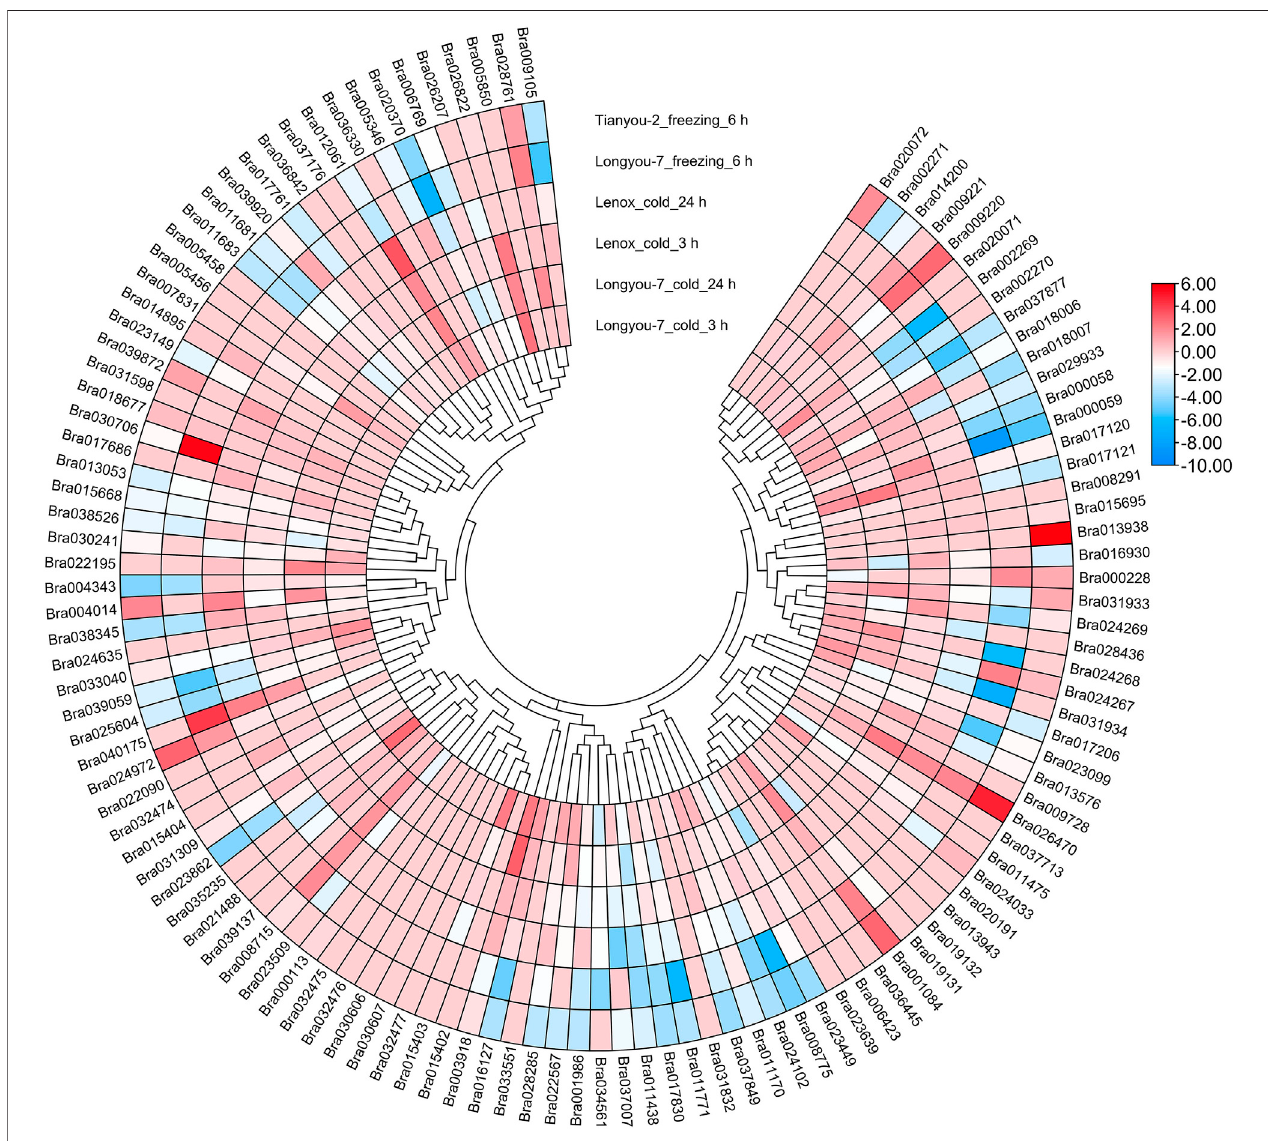
FIGURE 6 | The expression heatmap of BrAPXs of different cold-resistant varieties under different stress was plotted according to the log2 mean of FPKM in RNA-seq.